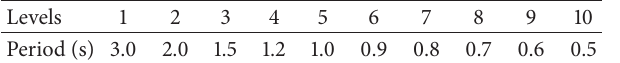
Table 2: Relationship between the difficulty levels and the periods of rhythmic stimuli in the immediate response task and delayed response task. Levels 1 2 3 4 5 6 7 8 9 10 Period (s) 3.0 2.0 1.5 1.2 1.0 0.9 0.8 0.7 0.6